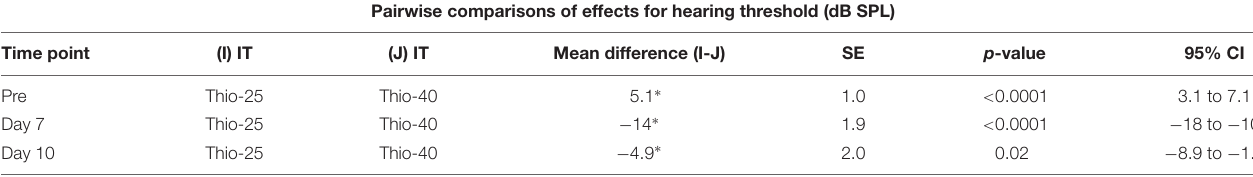
TABLE 1B | Pairwise comparisons of the analysis results presented in Table 1A . Pairwise comparisons of effects for hearing threshold (dB SPL)